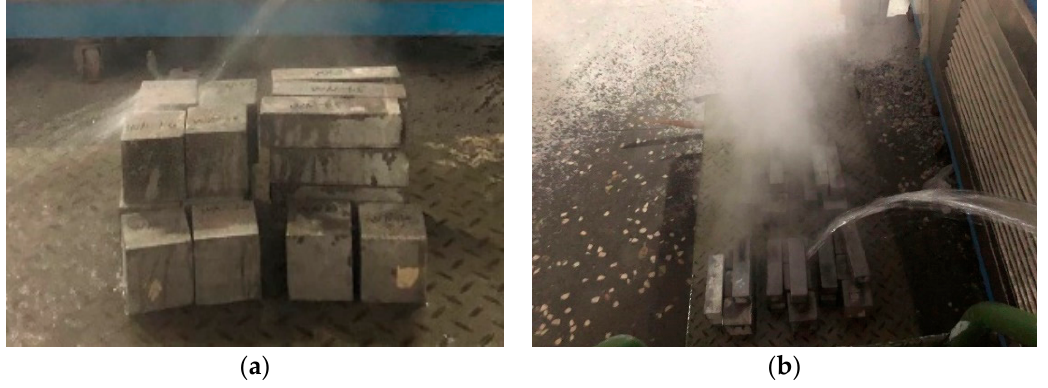
Figure 1. Cooling of specimens after high-temperature exposure. ( a ) 200 °C and ( b ) 600